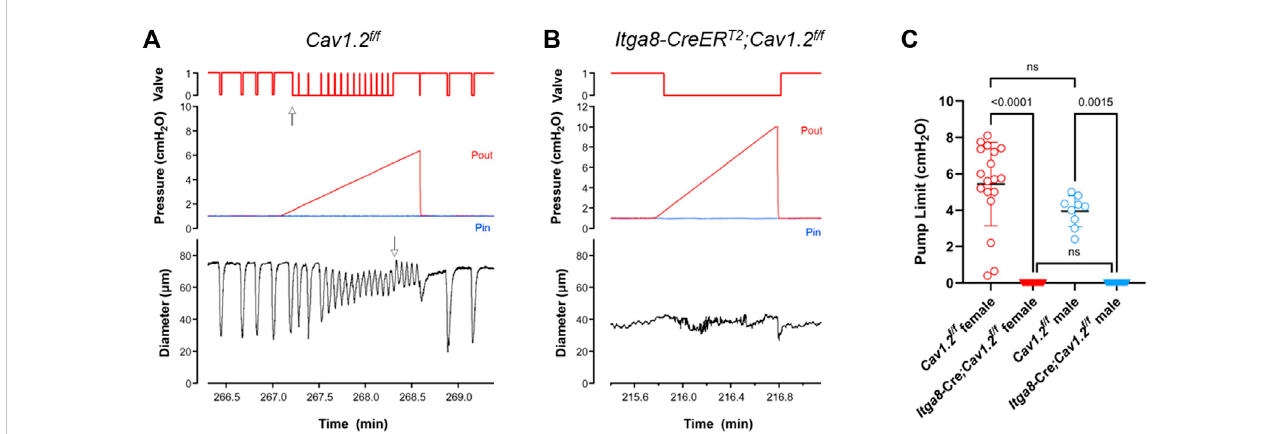
FIGURE 5 Pump tests for 2-valve popliteal lymphatic segments from Cav1.2 f/f mice and Itga8-CreER T2 ;Cav1.2 f/f mice. (A) Representative pump test for a Cav1.2 f/f popliteal vessel, showing theoutputvalve behavior (opening, closing with each contraction cycle even as Pout was elevated ramp-wise). (B) The output valve ina Itga8-CreER T2 ;Cav1.2 f/f popliteal vesselnever closed when pressures wereequal andnever openedwhenPout > Pin. Valve position:1 =open; 0= closed. Uparrowin (A) indicatespointintimewhenvalveispredominantlyclosedduringthecontractioncycle(duringthePoutramp)andopensonlyatthepeak of lymphatic systole. Down arrow in (A) indicates the point in time when the output valve locked open, immediately after the last ejection during lymphatic systole; the pump limit at that instant, as determined from Pout, was 5.3 cmH 2 O. Pout = red lines; Pin = blue lines. (C) Summary of pump test values from 3 male and 8 female Cav1.2 f/f vessels and 4 male and 6 female Itga8-CreER T2 ;Cav1.2 f/f